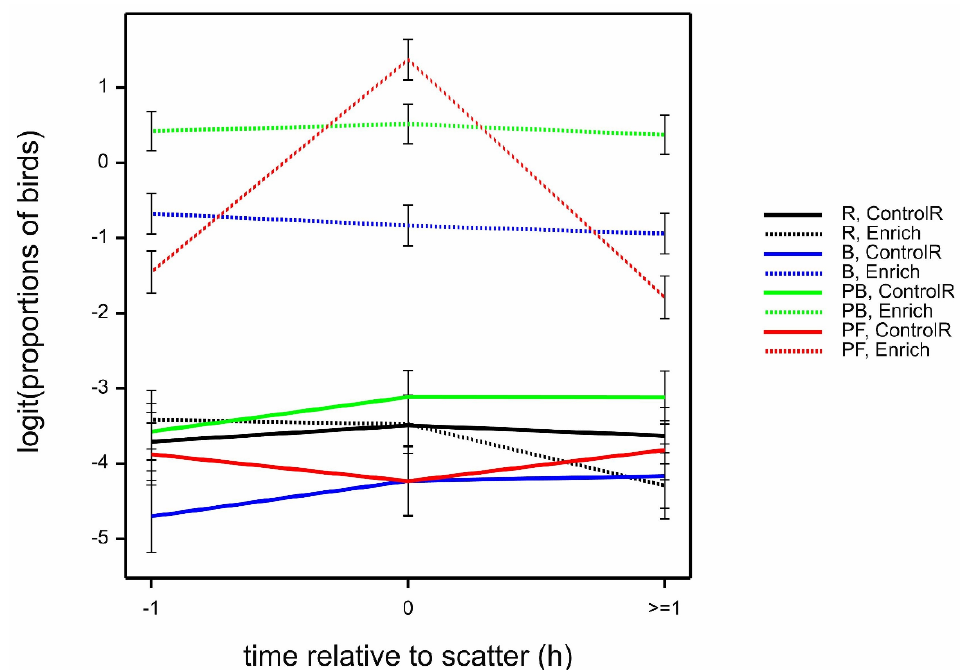
Figure 4. Mean ± SE logit (proportions of birds) observed interacting with enrichments, by time relative to scatter ( − 1, 0, ≥ 1) and location (ControlR, Enrich), estimated from GLMM. In all ControlR locations, the only enrichments present were ropes (R); in Enrich locations, there were ropes (R), bales + ropes (B), peck blocks + ropes (PB), or pelleted feed + ropes (PF).